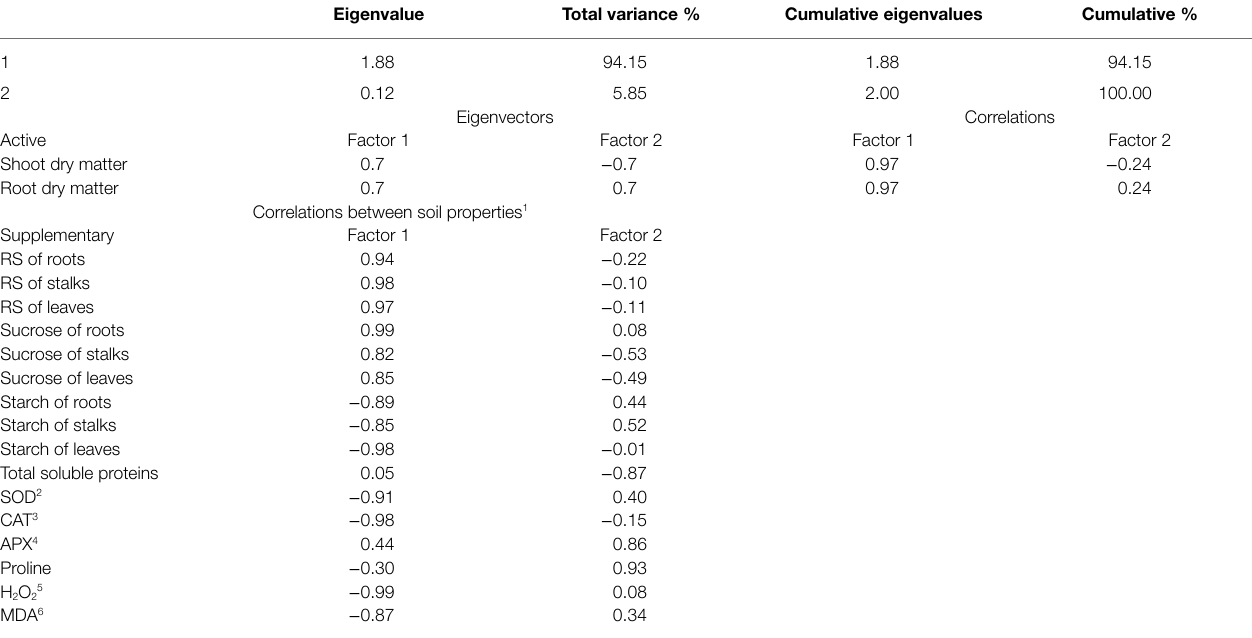
TABLE 1 | Principal component analysis results for plant biometric, metabolites, antioxidant enzymes, and amino acid and their correlations with sugarcane root and shoot dry matter. Eigenvalue Total variance % Cumulative eigenvalues